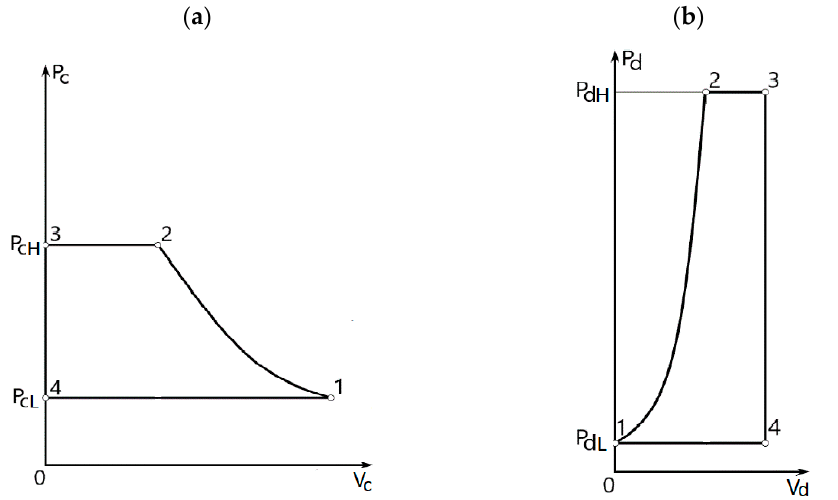
Figure 2. Pressure–volume change in the compressor ( a ) and driver ( b ) (indicator diagrams).